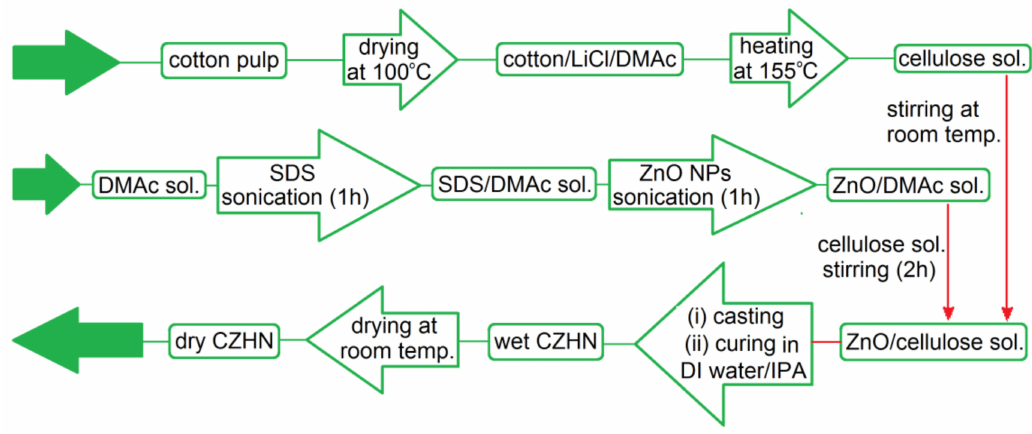
Figure 14. Fabrication procedure of a glucose oxidase-immobilized ZnO / cellulose composite film